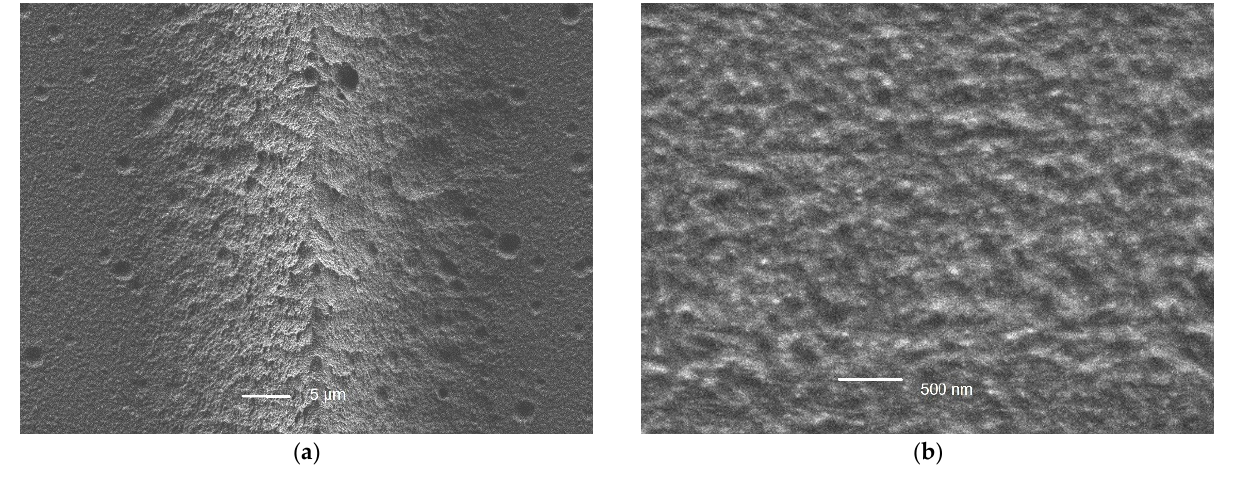
Figure 5. Nanoscale molding quality. LSR surface with ( a ) a linear groove structure and pyramid nanostructure (mold, see Figure 2b) and ( b ) a rod nanostructure (mold, see Figure 3b) after the molding process. The SEM picture of the LSR surface suffers from typical poor resolution.